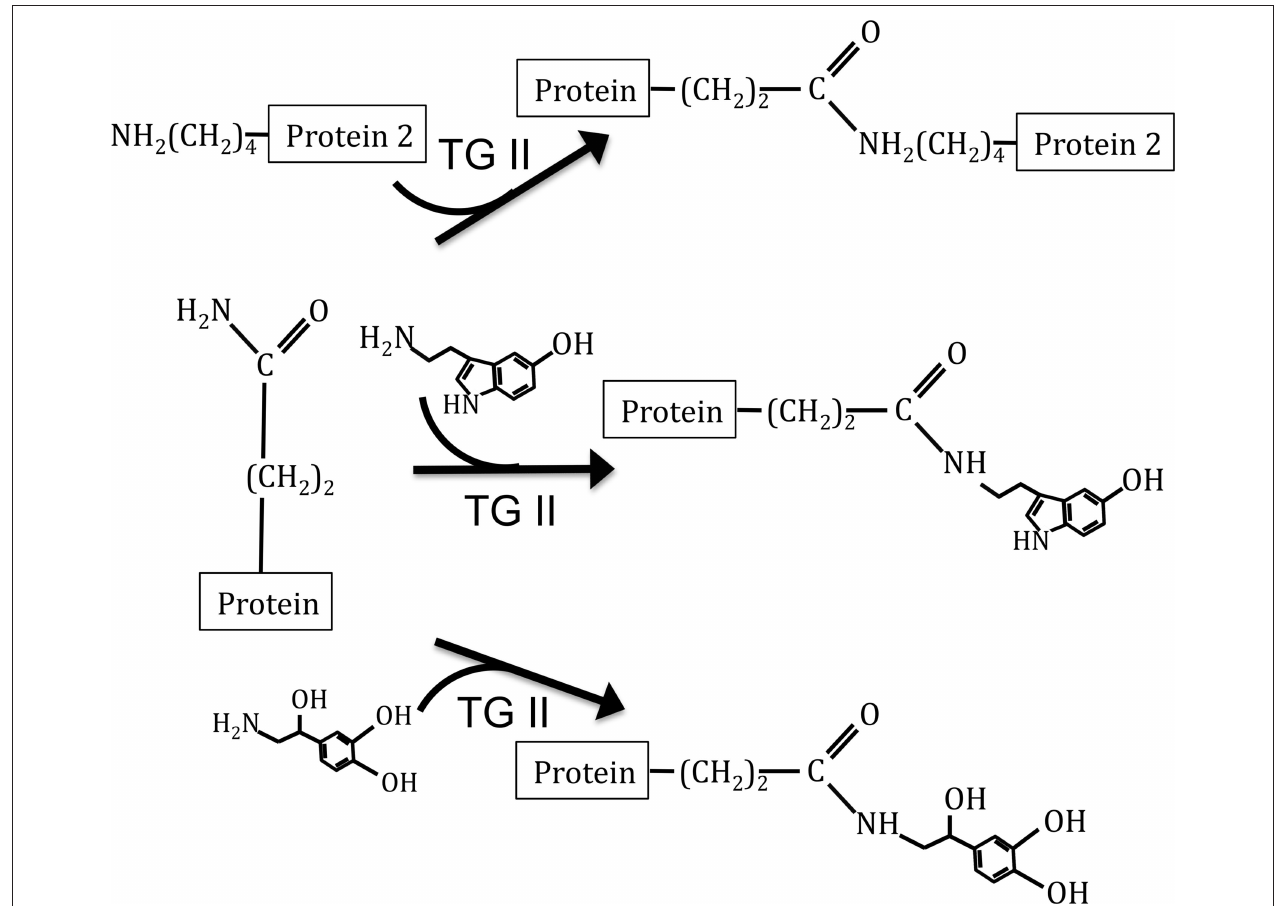
Figure 1 | Depiction of Tg ii catalyzed reactions. Top reaction depicts protein cross-linking reaction of TG II. The middle reaction depicts the addition of serotonin to proteins, a modification known as serotonylation. Bottom reaction depicts our hypothesized modification, the covalent linkage of NE to